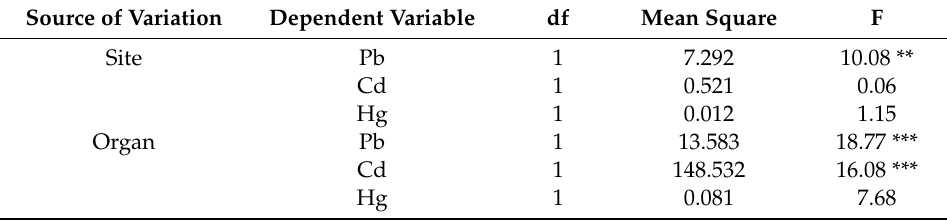
Table 1. Factorial analysis of variance (ANOVA) testing the effect from the collection site (Napoli versus Castellammare di Stabia), the accumulation organ type (muscle versus digestive gland) on the concentration of heavy metals (Pb, Cd and Hg) in Octopus vulgaris. df = degree of freedom. Probability levels for significant effects: p < 0.001 (***); p < 0.01 (**); p < 0.05 (*). MS = mean squares; F = F-ratio.